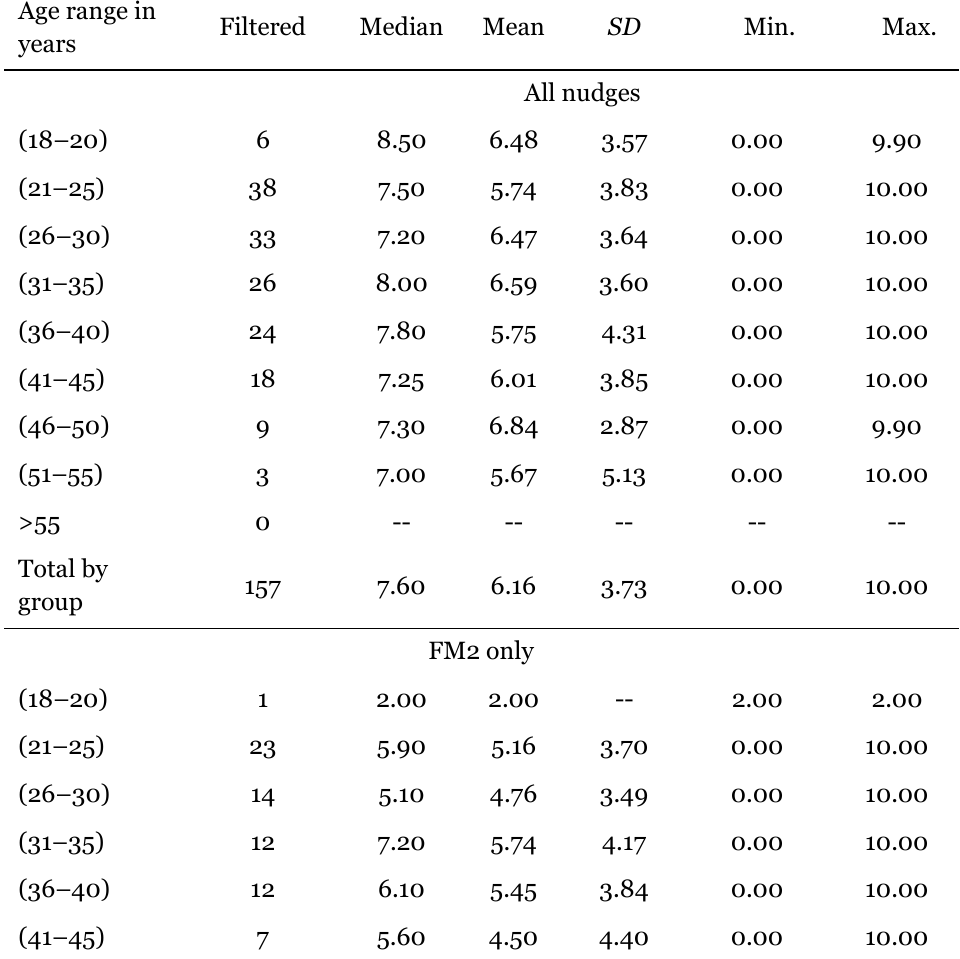
Final Mark Distribution: Descriptive Statistics for Each